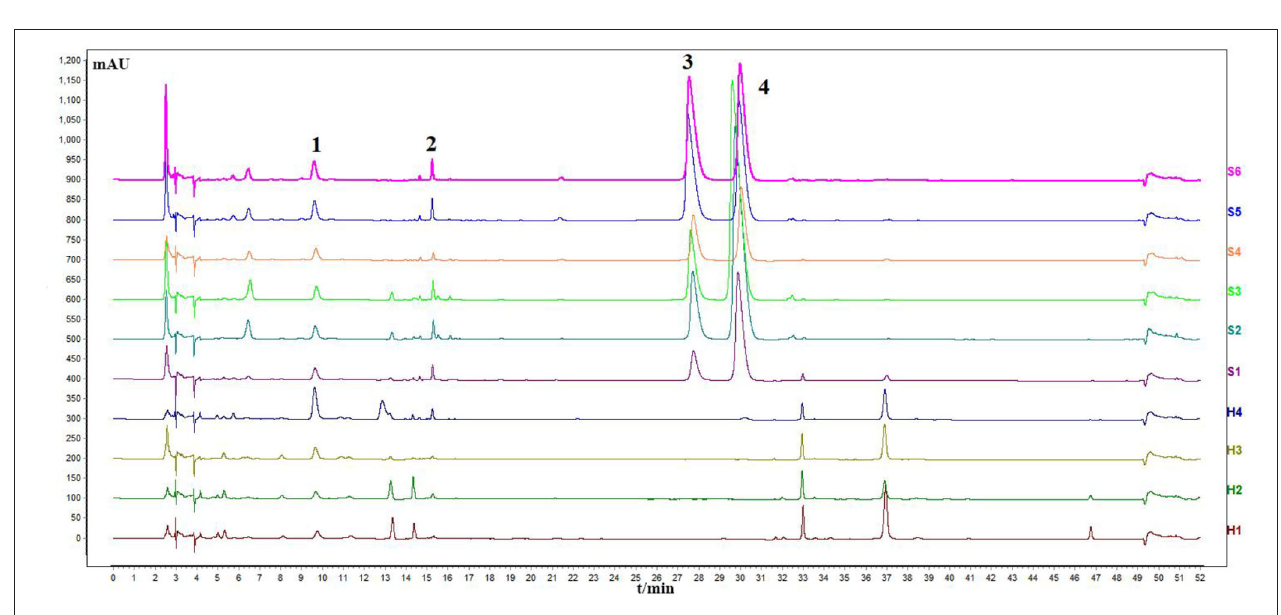
FIGURE 3 | Chromatogram of HPLC content determination of P. harmala L. S1–S6, the seeds; H1–H4, the aerial